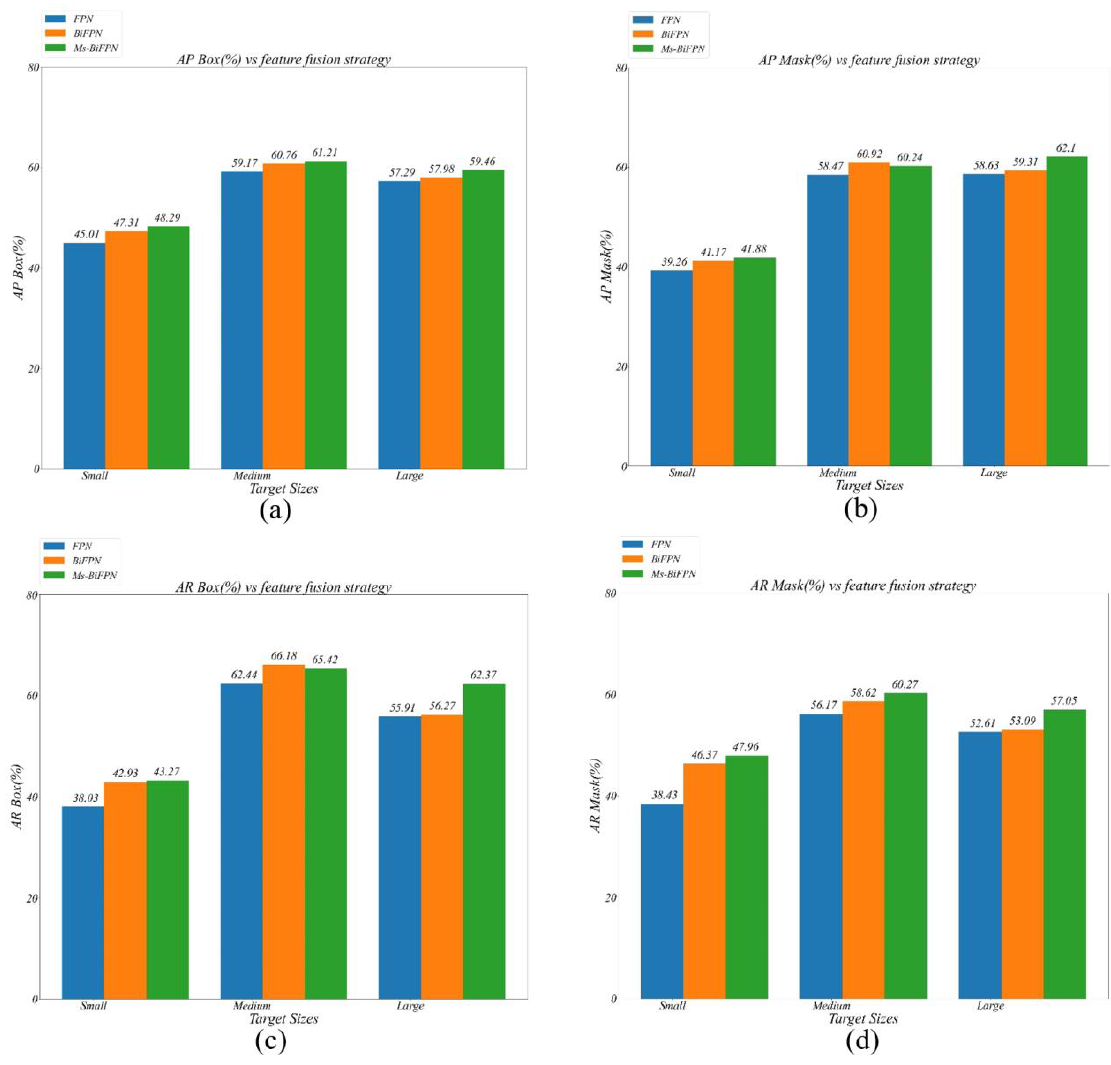
Figure 21. The comparison of AP and AR metrics under different algae size: ( a ) are the results of AlgaeFiner in AP box under the different fusion strategies, ( b ) are the results of AlgaeFiner in AP mask under the different fusion strategies, ( c ) are the results of AlgaeFiner in AR box under the different fusion strategies, and ( d ) are the results of AlgaeFiner in AR mask under the different fusion strategies.